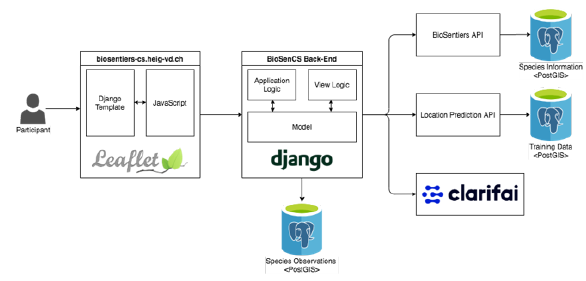
Figure 1. The high-level architecture of BioSenCS application